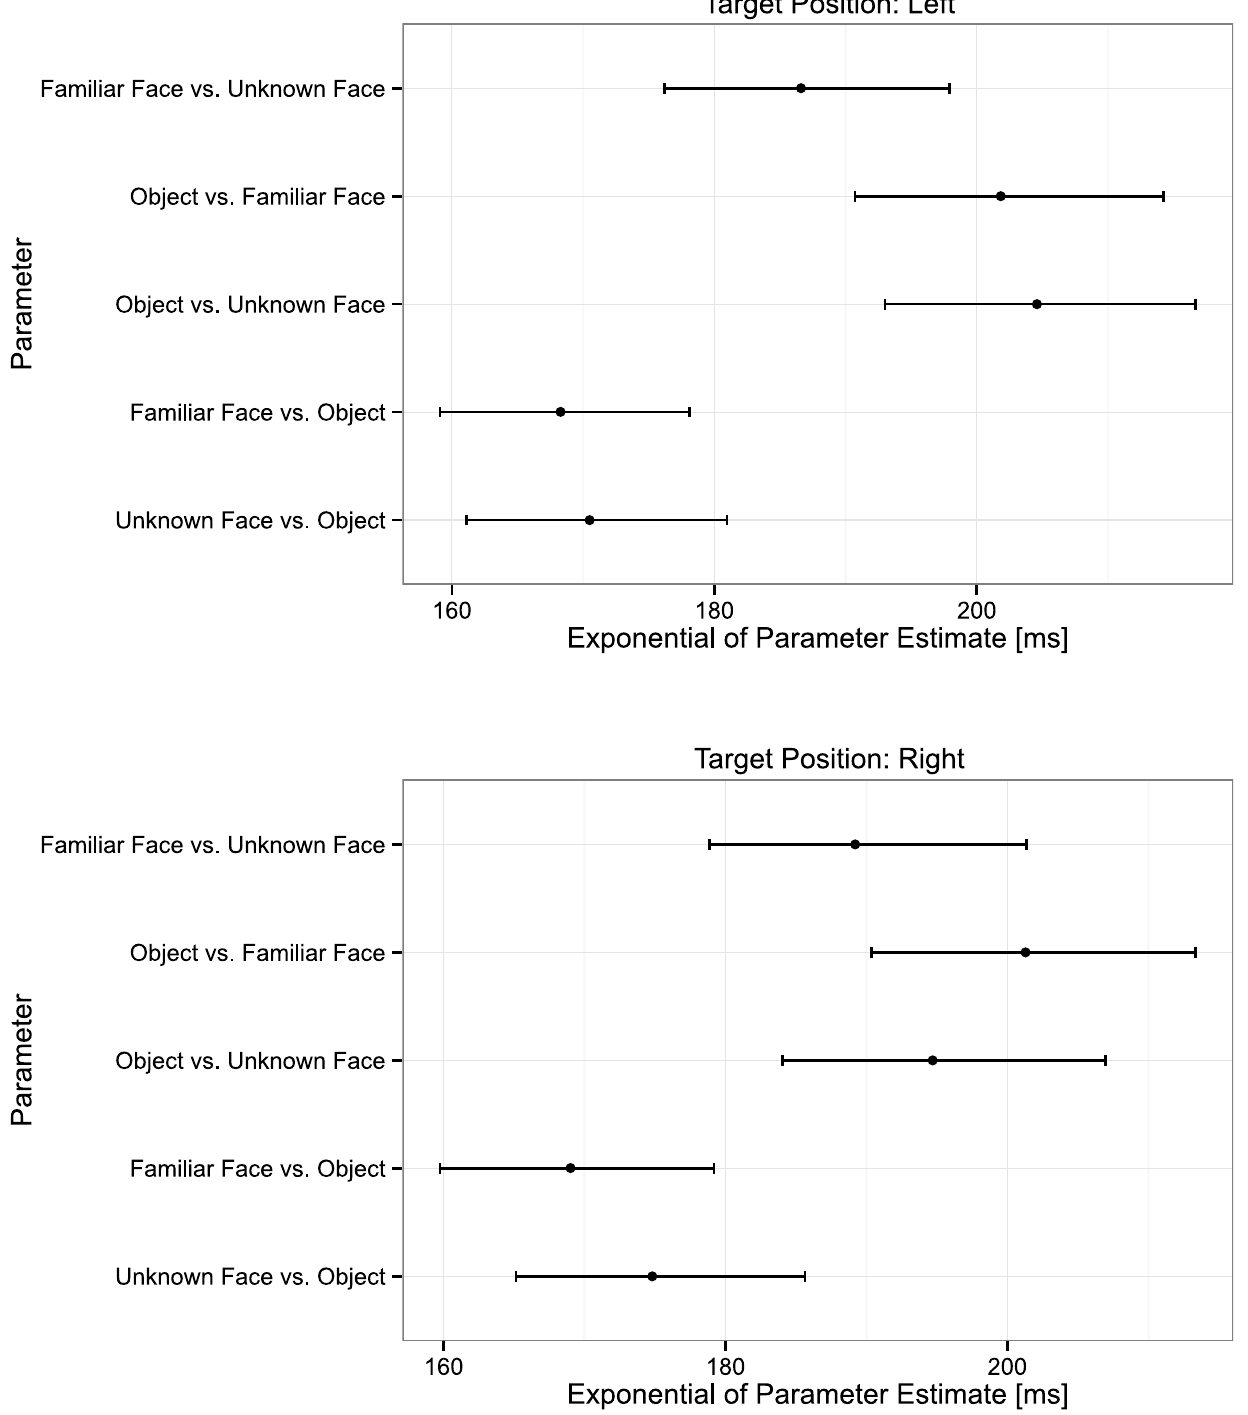
PLOS ONE | DOI:10.1371/journal.pone.0136548 August 25,